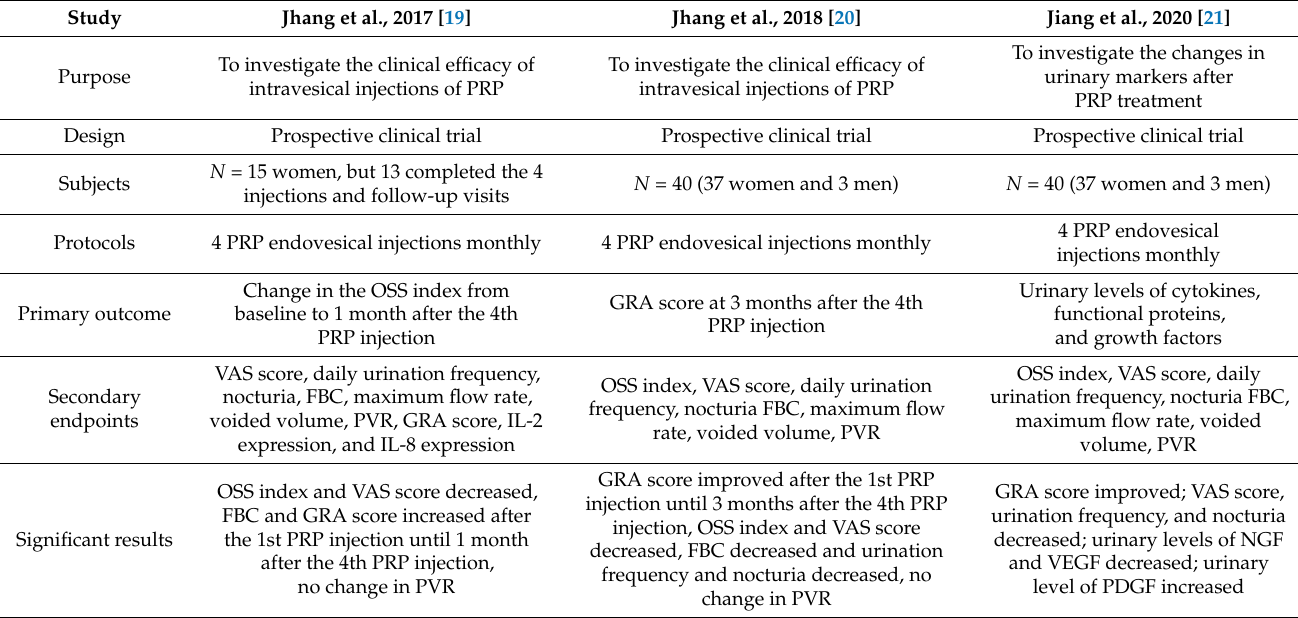
Table 2. Main features of the clinical trials